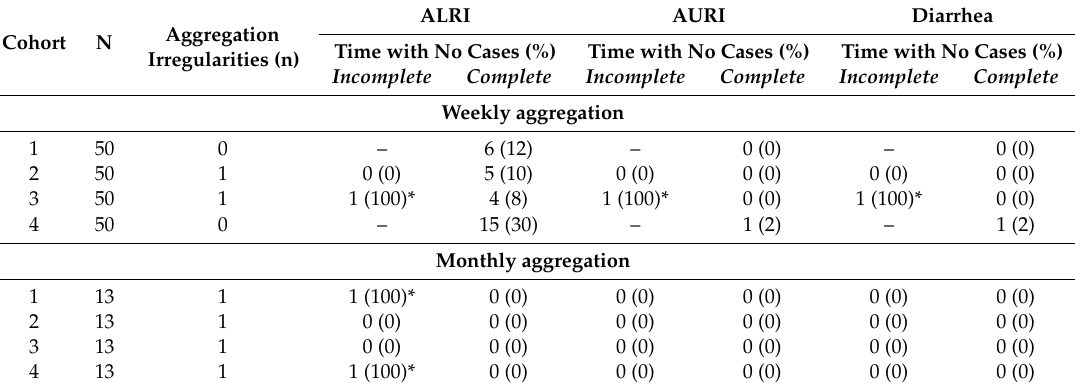
Table 4. Number of weeks and months that have zero observed cases of ALRI, AURI, and diarrhea. * when all weeks or months had no observed